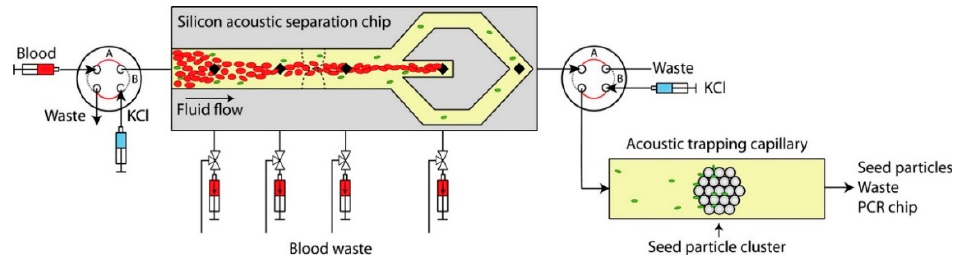
Figure 7. Bacteria were separated from red blood cells using acoustic separation, enriched, and then released to dry-reagent PCR chips for detection [224]. Reproduced from the mentioned reference with permission from the related journal.